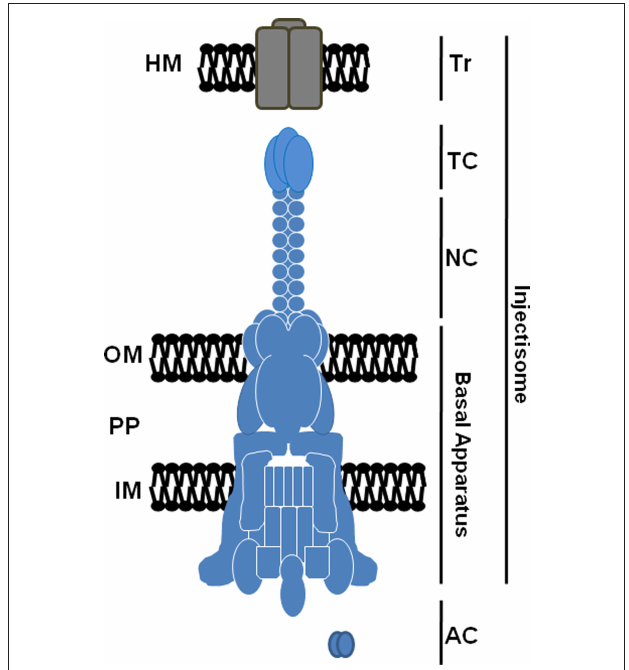
Figure 1 | Schematic representation of a prototypical T3S injectisome. Components including the translocator (Tr), tip (TC), and needle (NC) complexes, basal apparatus, and cytoplasmic ancillary proteins (AC) are shown. The basal apparatus spans the bacterial inner membrane (IM), periplasm (PP), and outer membrane (OM). Secreted translocon components are shown localized to a host membrane (HM). Correct stoichiometry of multimeric proteins is not